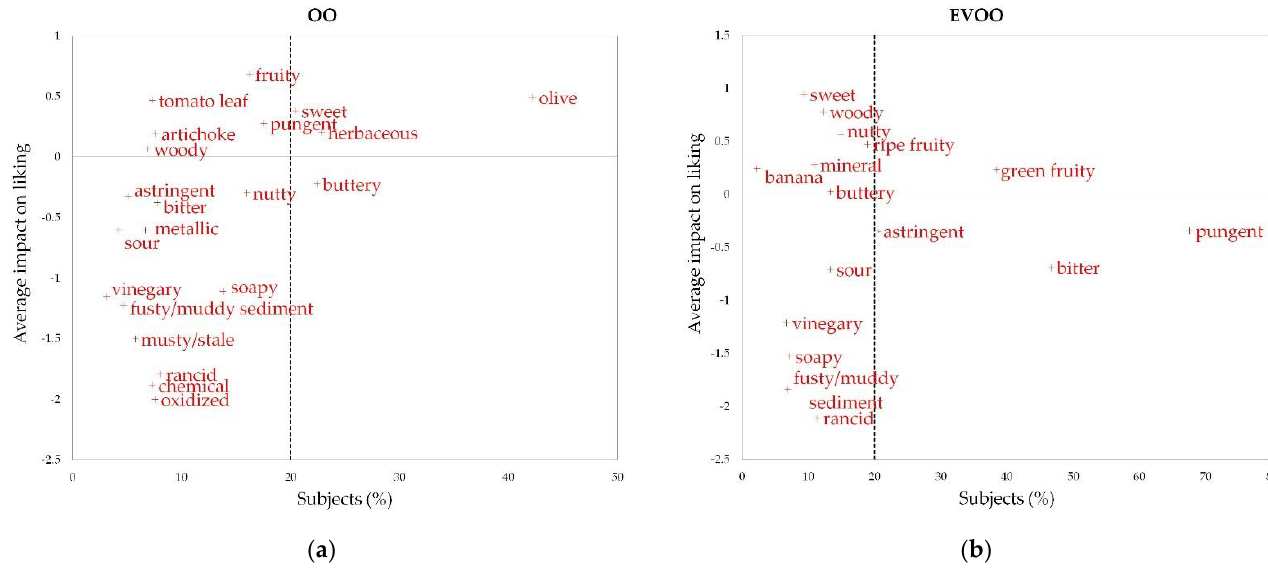
Figure 2. Penalty charts showing the impact of the sensory attribute perception on the overall liking of oils estimated with consumers. ( a ) Olive oils; ( b ) extra-virgin olive